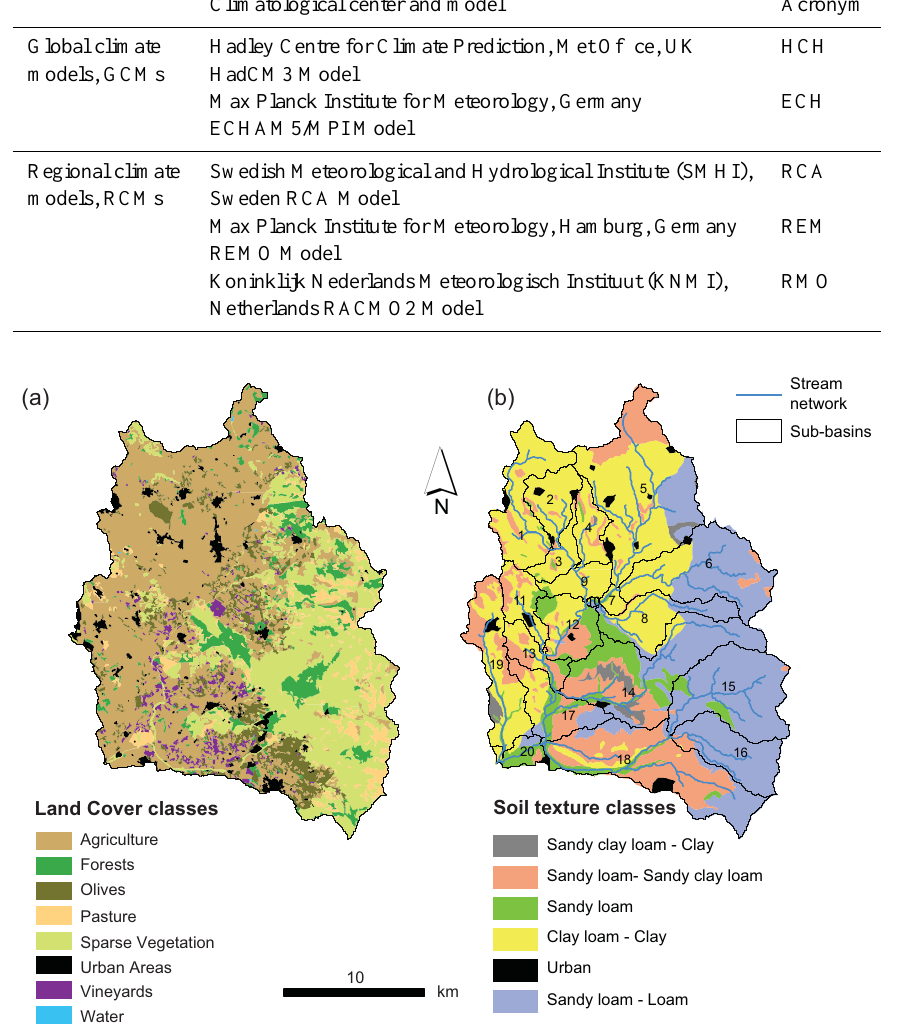
Figure 2. (a) Land cover and (b) soil texture maps used as input for the tRIBS model. In (b) , the boundaries of 20 sub-basins are also reported along with the stream